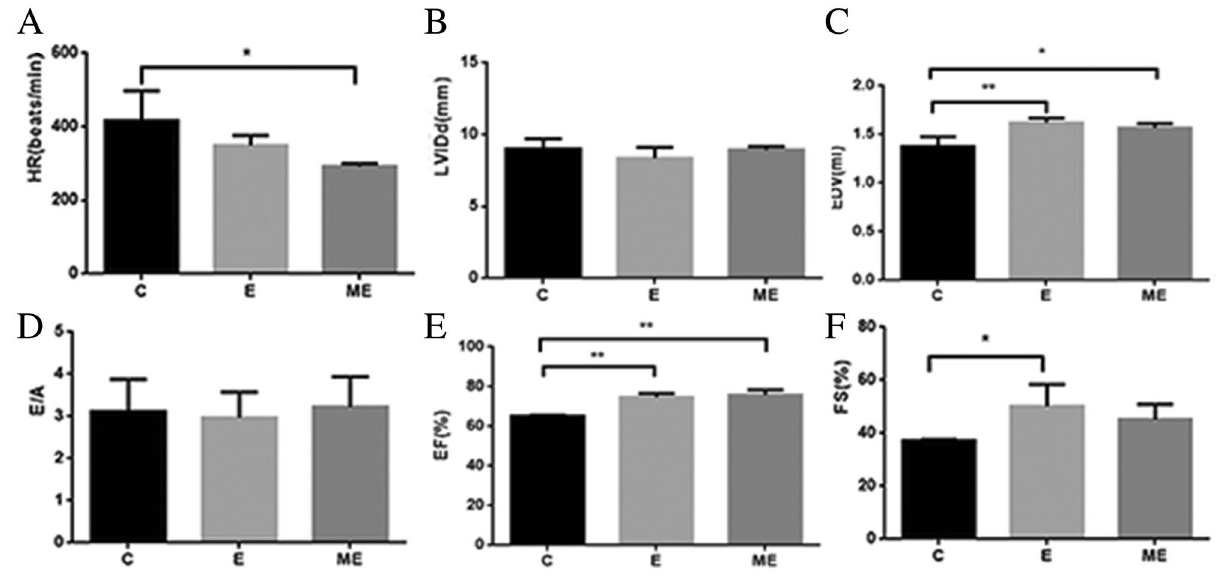
Figure 3. Changes of cardiac structure and function after MOTS-c. ( A ) The HR in group ME was lower than in group C. ( B ) There were no differences in LVIDd among these three groups; ( C ) The EDV in group E and ME was higher than in group C; ( D )There were no differences in E/A among these three groups; ( E ) The EF in group E and ME was significantly higher than in group C; ( F ) The FS in group E was higher than in group C.